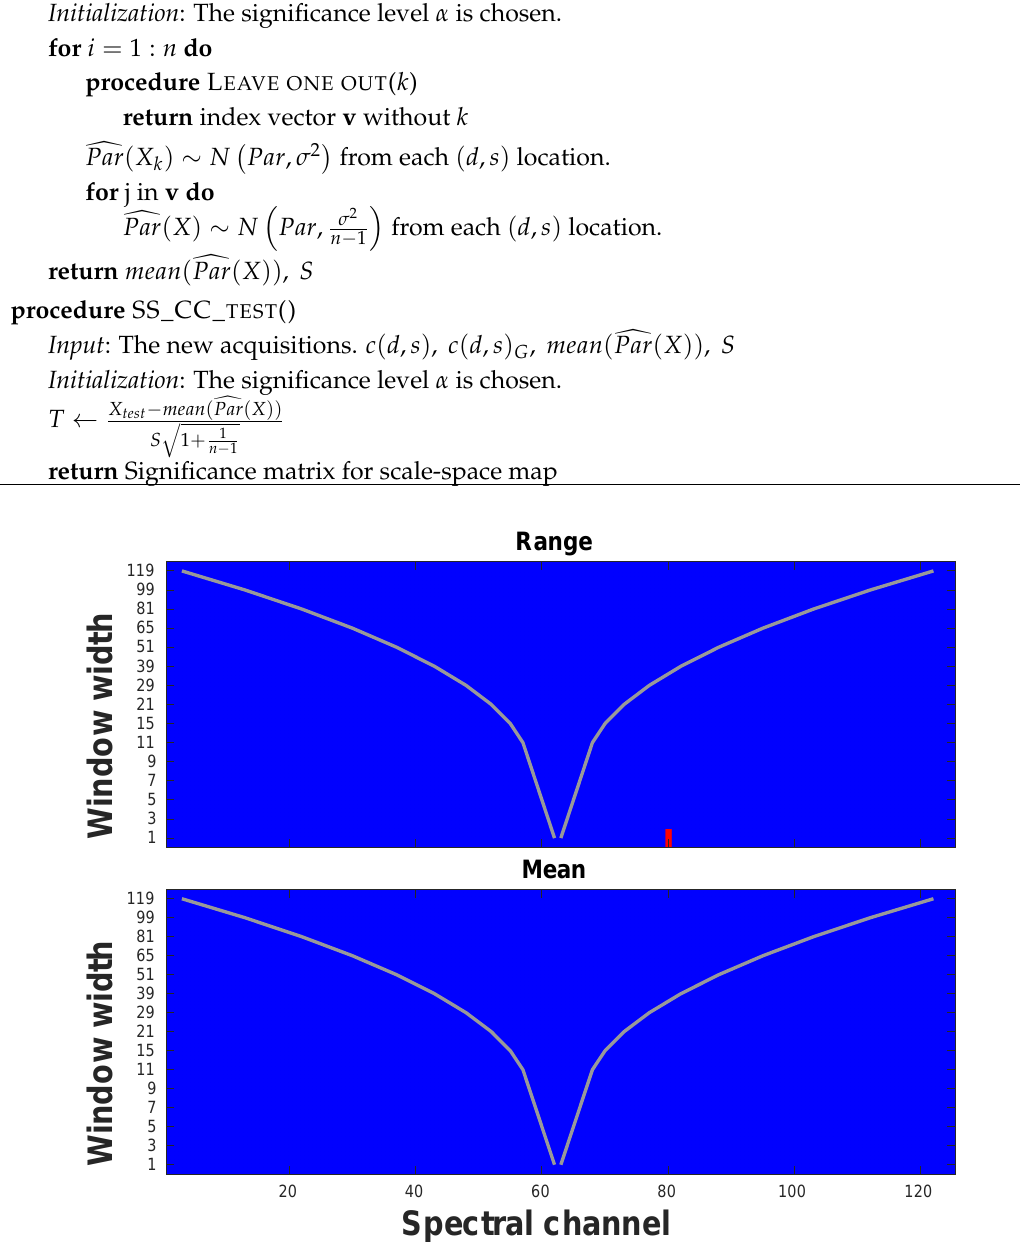
Figure 2. Scale-space significance map for the comparison between the hyperspectral image of a skin mole and an image obtained by manually distorting it. The original and distorted spectral signatures are shown in Figure 1. For the tests, the Hannig-Marron global rejection threshold was used both for the range and the